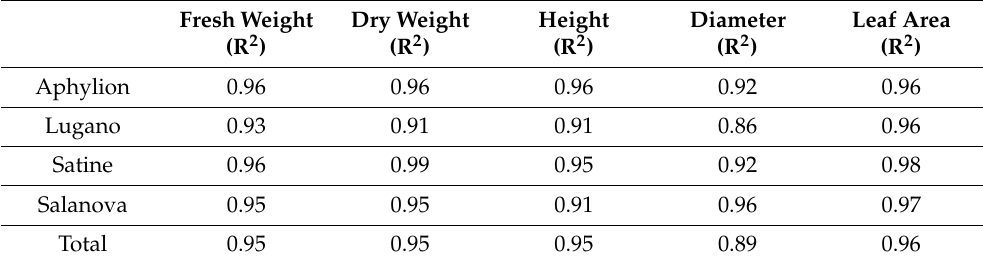
Table 4. Comparison of R 2 values of four lettuce varieties.